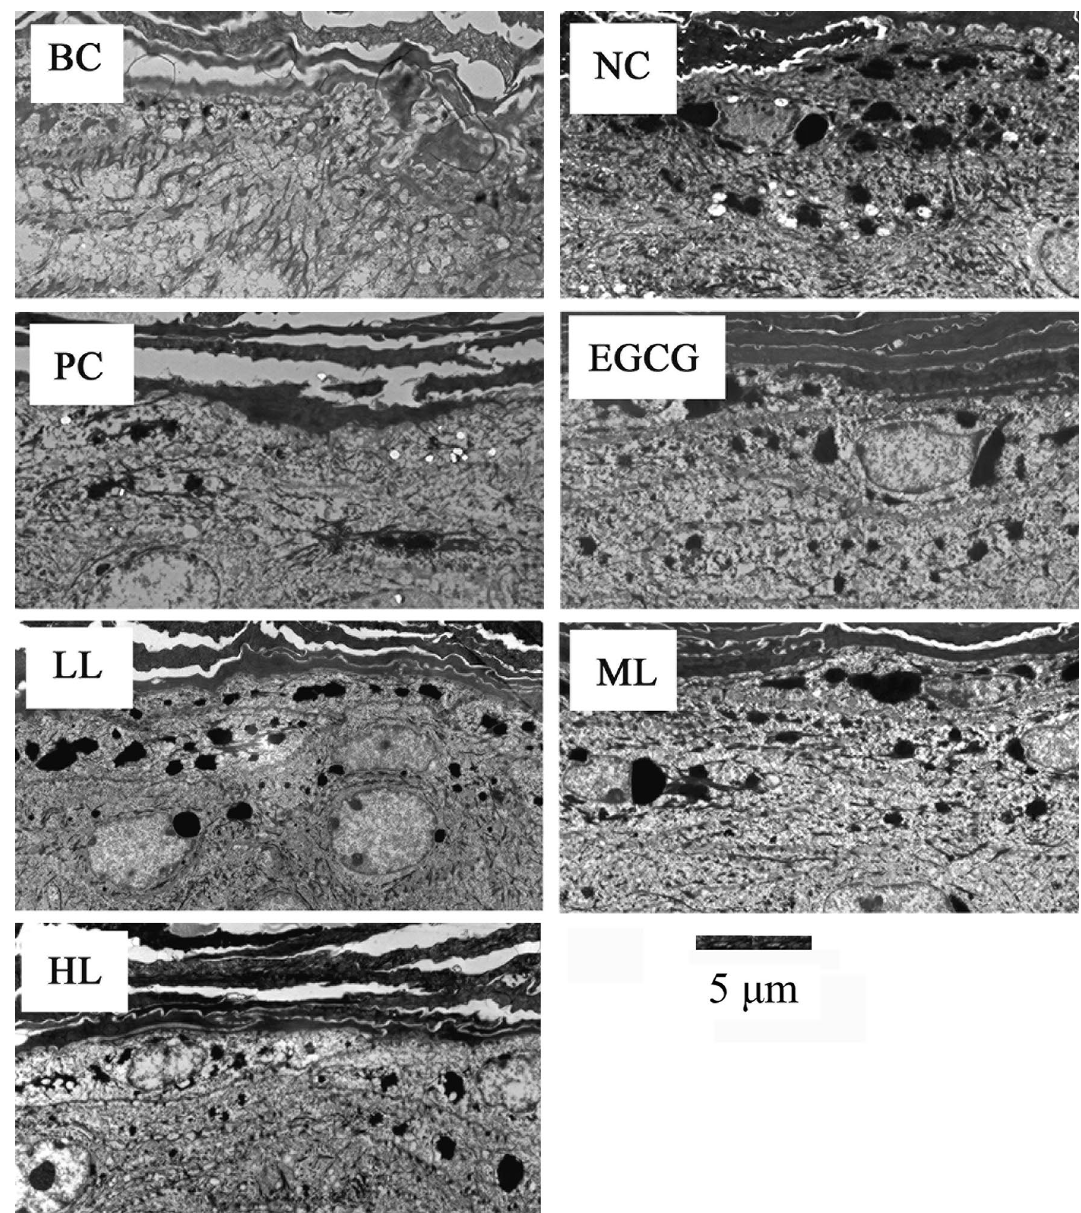
Figure 2. Effects of GCG on UVB-induced melanosome formation in female hairless mice skin. BC blank control, NC negative control, PC positive control, EGCG EGCG treatment, LL low level GCG treatment, ML medium level GCG treatment, HL high level GCG treatment, dark dots: